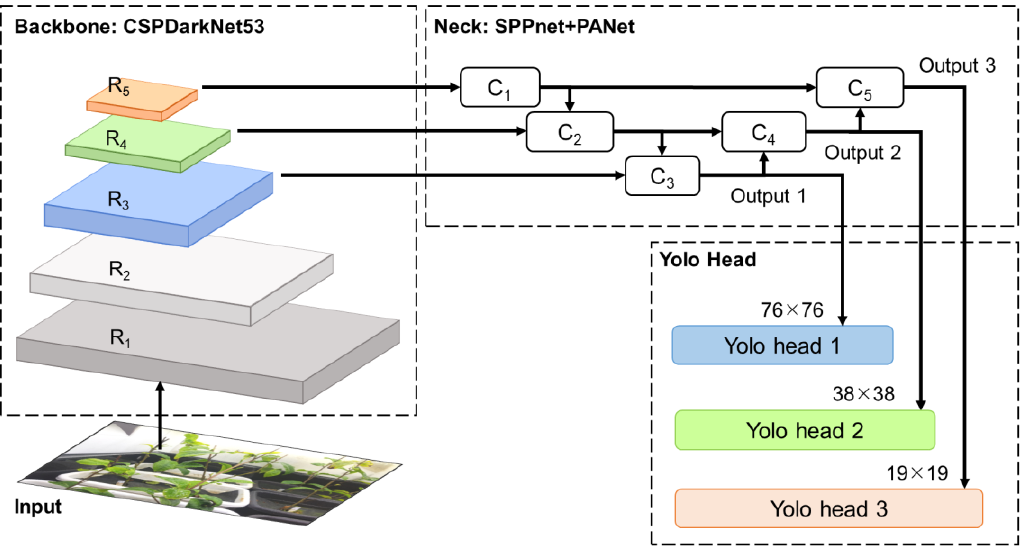
Figure 9. The structure of YoLov4 model, which includes a backbone network based on CSPDarknet53 (backbone), feature fusion layer (neck), and YoLo head. SPPnet and PANet are included in neck. Feature maps of different scales (R 3 -R 5 ) are output to YoLo head 1, YoLo head 2, and YoLo head 3 after feature fusion processing (C 1 -C 5 ).